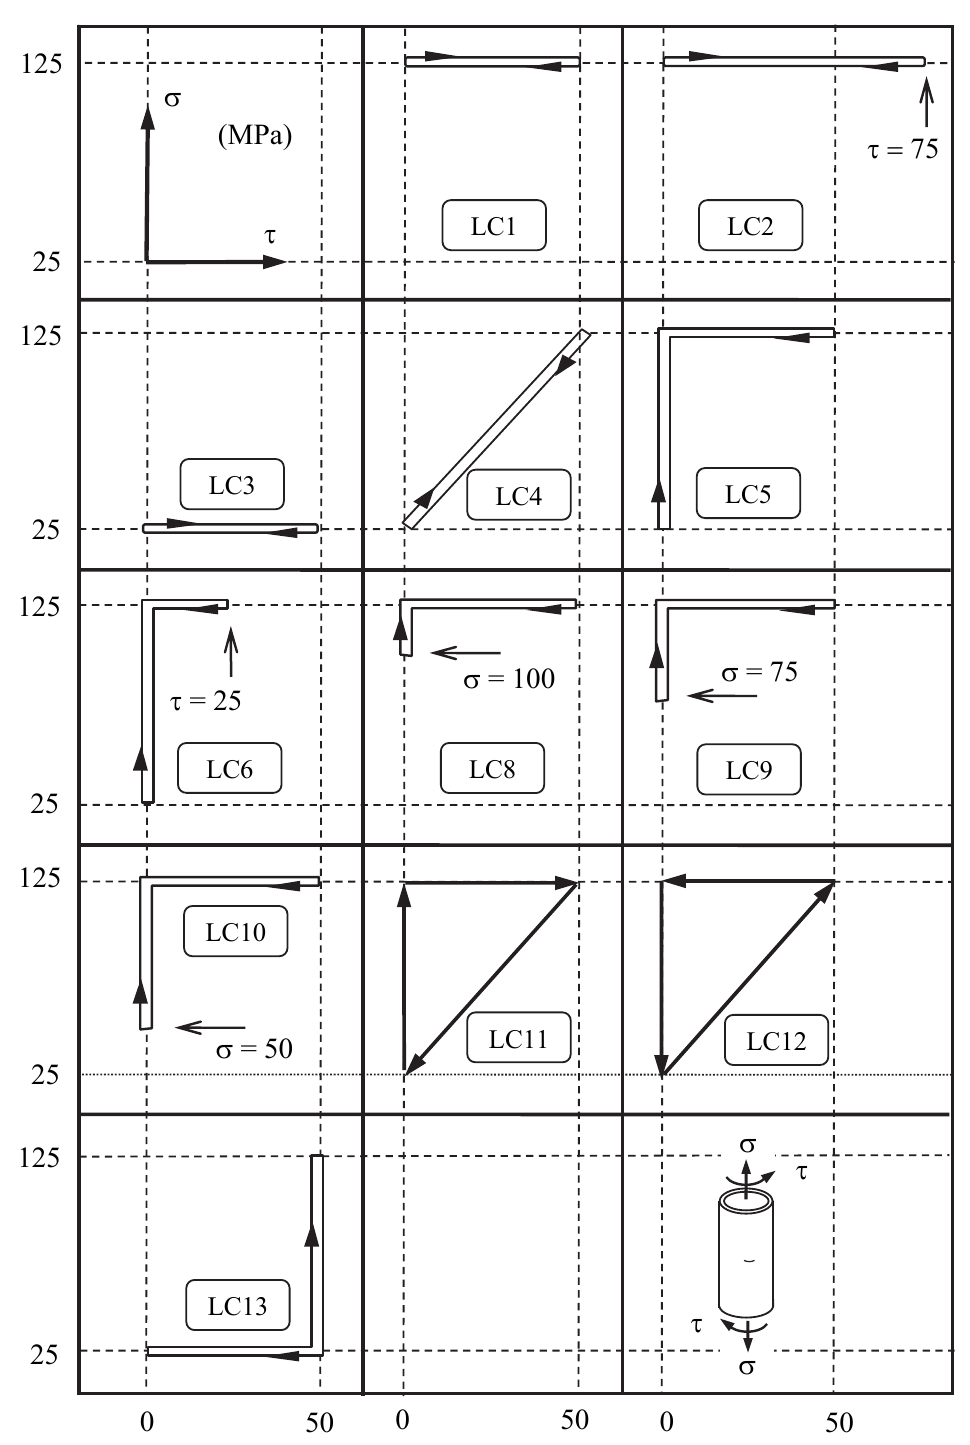
Figure 3: Load cases applied during the phase 2 of the fatigue